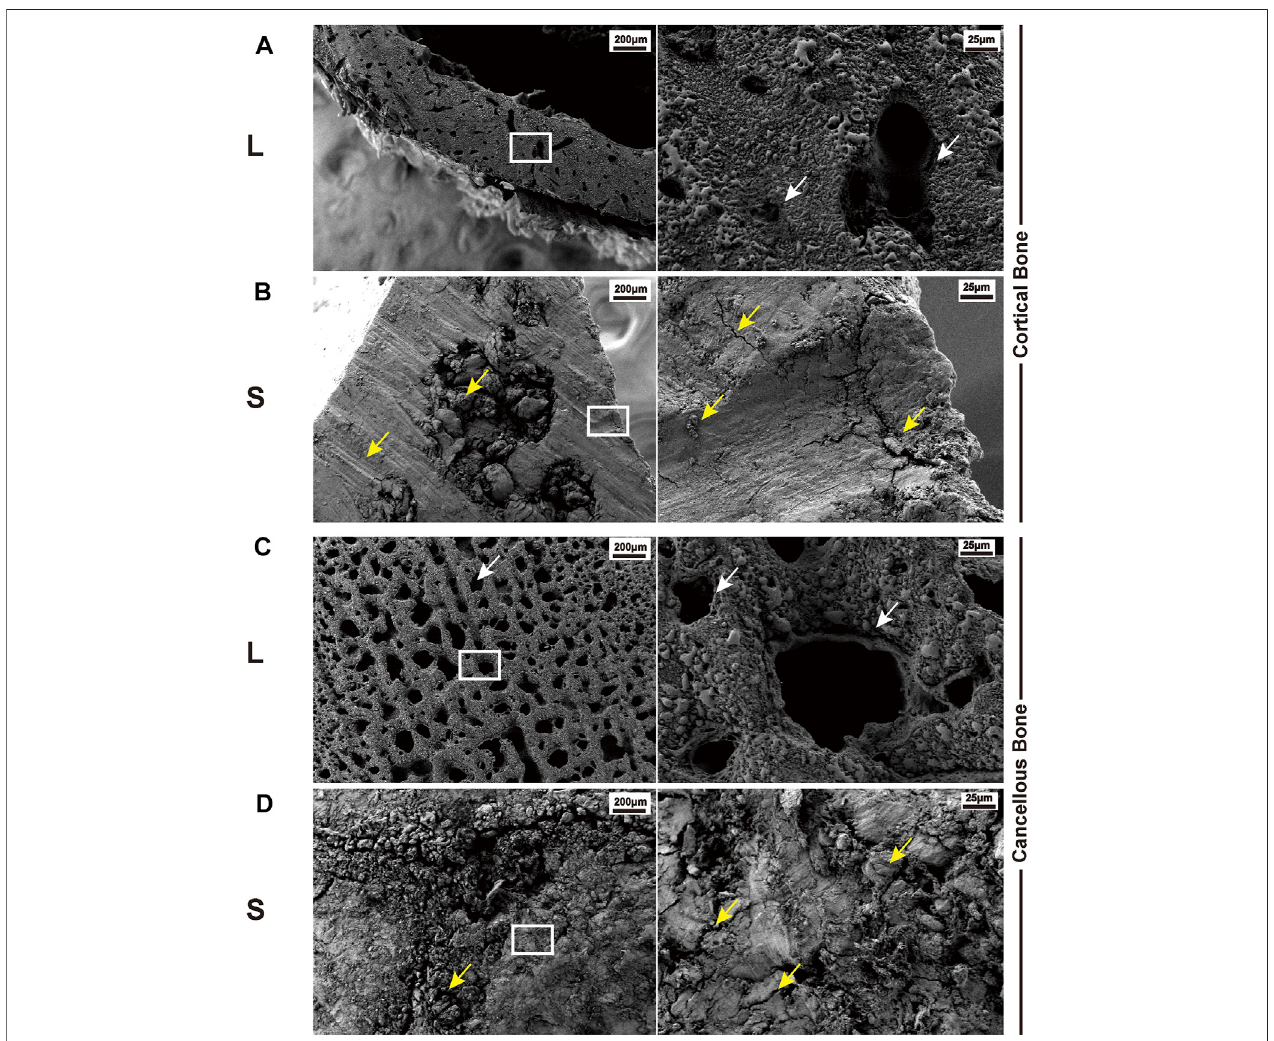
FIGURE 3 | Typical SEM images of bone surface cutting by the laser and mechanical saw. (A) Cortical bone surface produced by laser osteotomy; white arrows indicatethetrophoblastvascularlumenandHaversiancanal. (B) Corticalbonesurfaceproducedbymechanicalsawosteotomy;yellowarrowsindicateabrasionmarks, cracks, and bone chips caused by the saw blade. (C) Cancellous bone surface produced by laser osteotomy; white arrows indicate the trabecular bone and the space between the trabecular bones. (D) Cancellous bone surface produced bymechanical saw osteotomy; yellow arrows indicate cracks and bone chips. White boxes indicate the cut-out after the subsequent magni fi